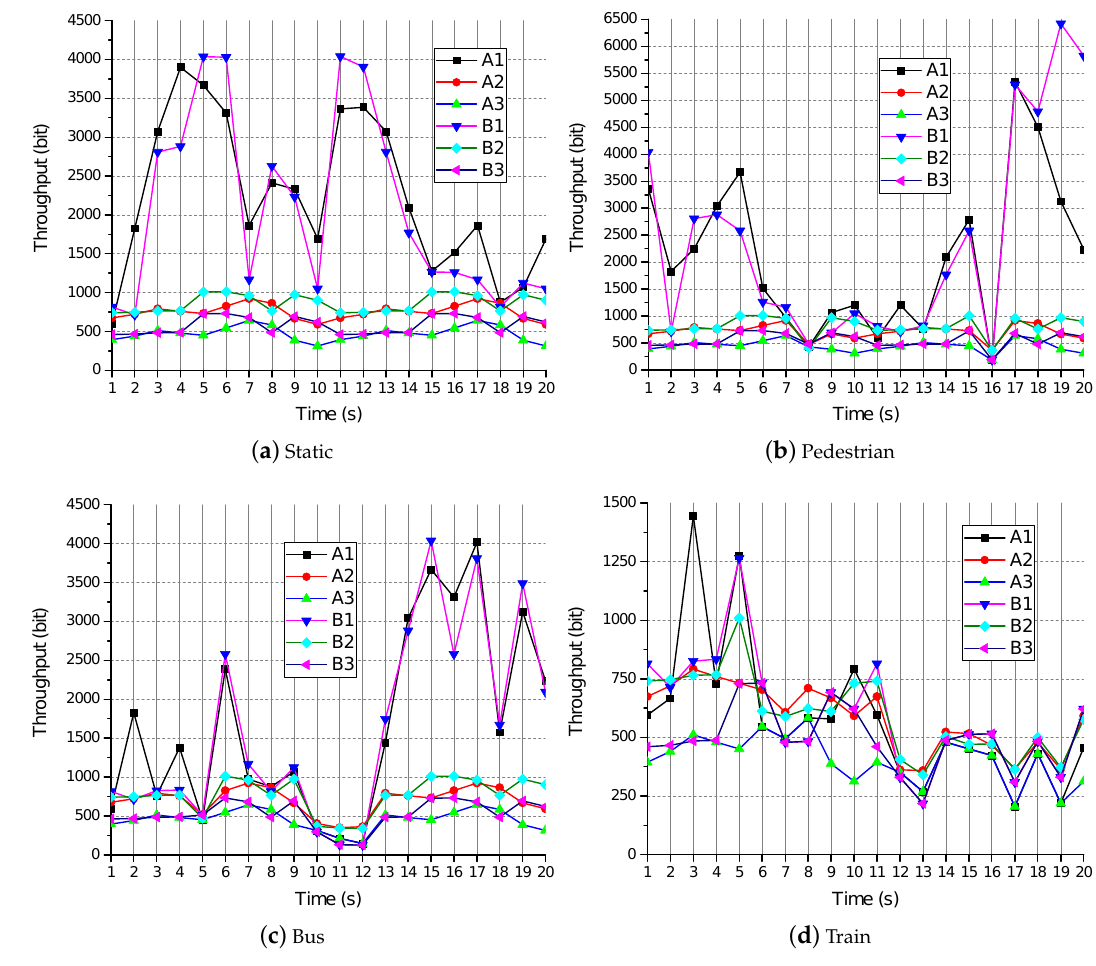
Figure 5. The throughput in different network